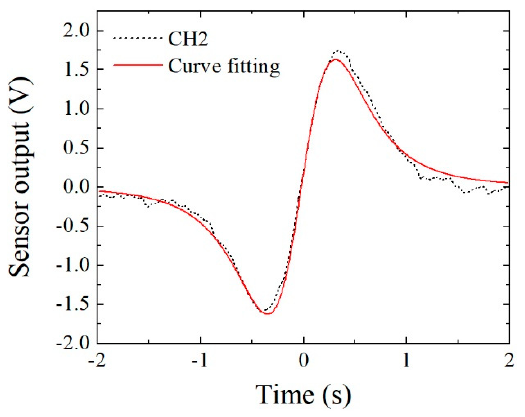
Figure 26. Application of curve fitting using the derived Equation. Figure 27 indicates the difference of the obtained peak point between the raw data and the curve-fitting data. The difference was almost 10%, and curve-fitting underestimated it in this case.